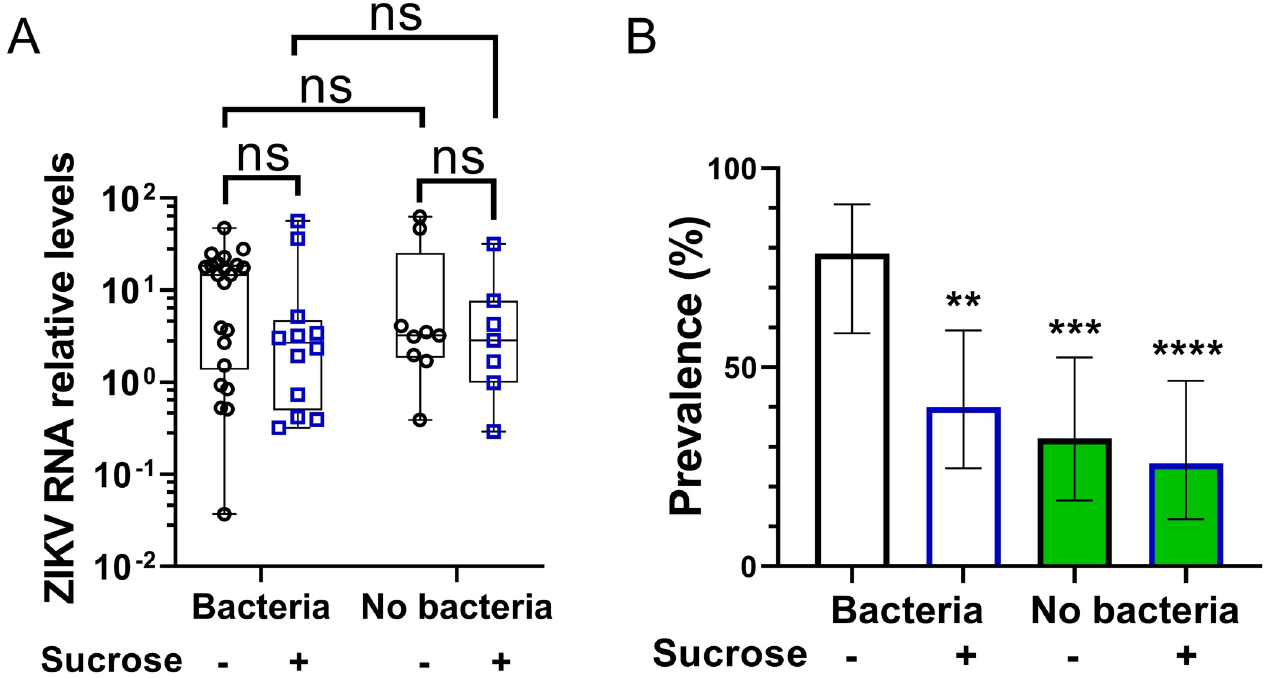
Fig 7. Sugar feeding protects the female mosquito Ae . aegypti against ZIKV infection. Females were treated as in Fig 5A except that females received a ZIKV-infected blood meal at a titre of 5.3 x 10 6 PFU/mL. All females were given access to sucrose solution 30 h after infectious blood meal. (A) ZIKV RNA levels, relative to S7 ribosomal protein transcript, in individual whole females assessed by RT-qPCR. Data were analysed as described (88) so as the RQ geomean of the group ‘No antibiotics-No sucrose’ is 1. N = 27 to 30 females per condition. Only ‘highly infected’ samples (with Ct less than 30, samples with Ct superior to 30 were considered as weakly infected or not infected) were plotted on the graphs. Box plots display the minimum, first quartile, median, third quartile, and maximum RQ values. Log2-transformed values of RQ values were analysed using two-way ANOVA (statistical analysis summary of treatment effect and interaction between treatments given in S4 Fig). Pair-wise comparisons shown on the graphs were obtained with a post hoc Fisher’s multiple comparison test (No sucrose vs Sucrose, Bacteria vs No bacteria). (B) ZIKV infection prevalence (in percentage). Lower and upper limits of the 95% confidence interval were calculated using the Wilson score interval method with a correction for continuity. Statistical significance of the treatment effect on prevalence were assessed with a Chi-square test (compared to No bacteria- No sucrose group). ns, p value > 0.05; �� , p value < 0.01; ��� , p value < 0.001; ���� , p value < 0.0001. Numbers of infected females and total number of females per group detailed in S6